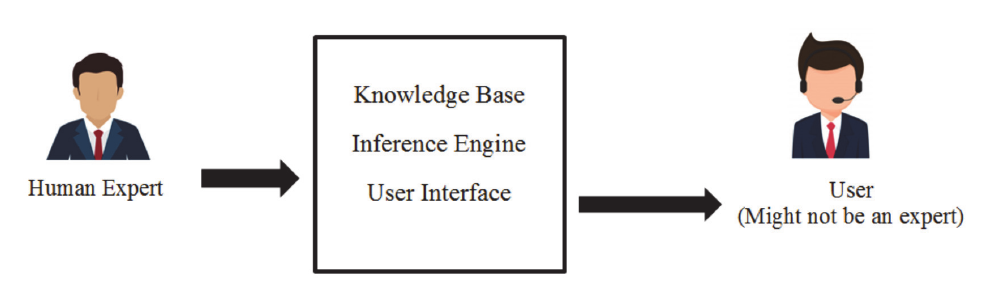
Fig. 2. Simplified Expert